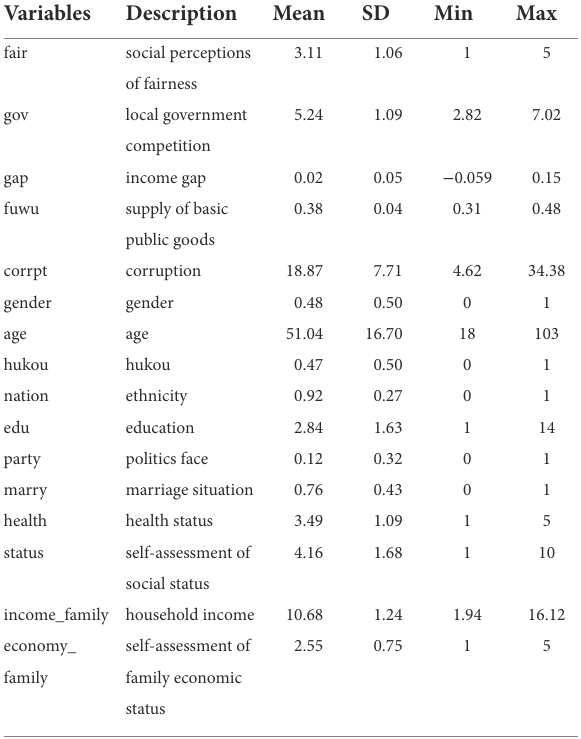
TABLE 1 Descriptive statistics of main